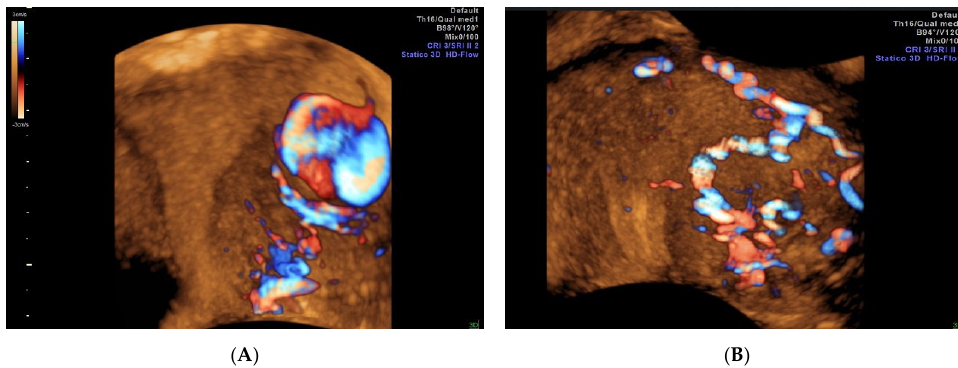
Figure 4. ( A ) 3D-HD flow color Doppler rendering image showing turbulent arterial flow into the anechoic area deriving from the right uterine artery vessel. ( B ) 3D-HD flow rendering image after the first embolization procedure showing the persistence of the flow deriving from a collateral branch of the left uterine artery vessel. Detection of vascular malformation within the uterus is not straightforward and differential diagnosis must be carried out to consider the full range of possibilities. For instance, gestational trophoblastic neoplasia (GTN) tumor is another cause of vascular